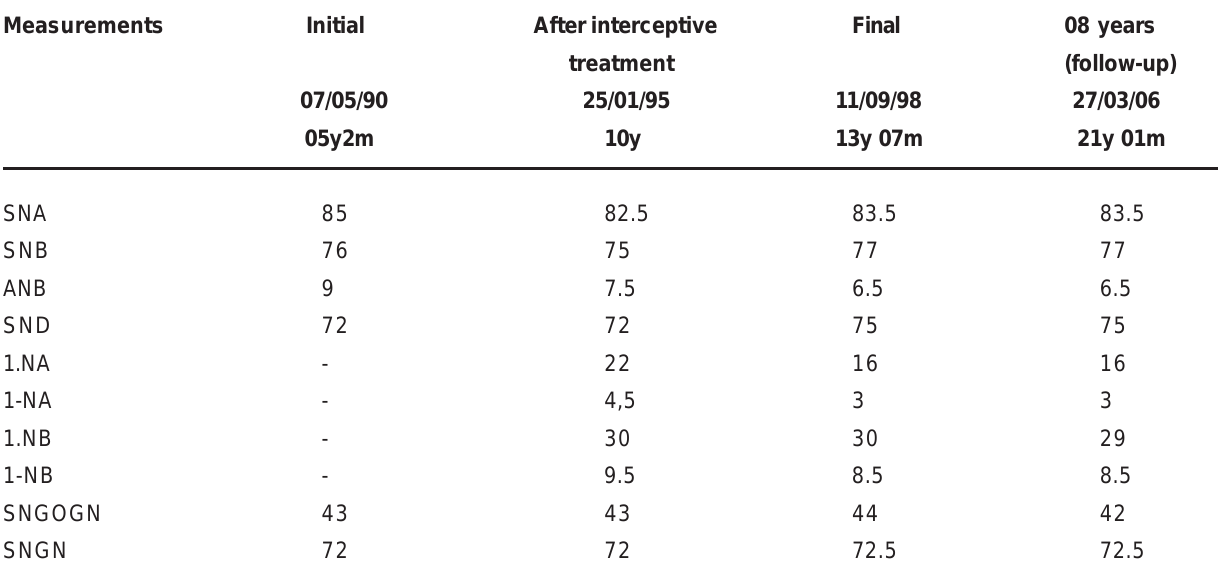
TABLE 1- Cephalometric measures of the patient at the beginning, end of treatment and follow-up